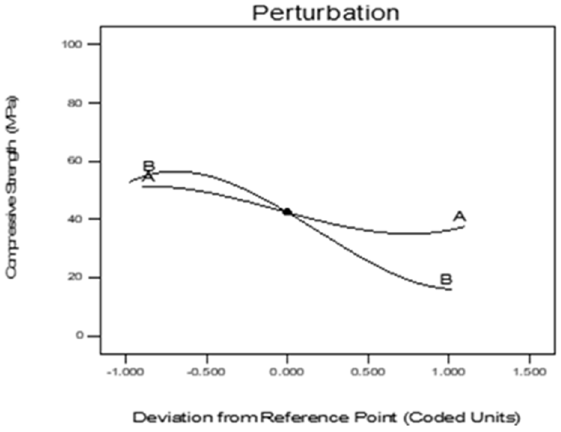
Figure 12. Perturbation plot of compressive strength.